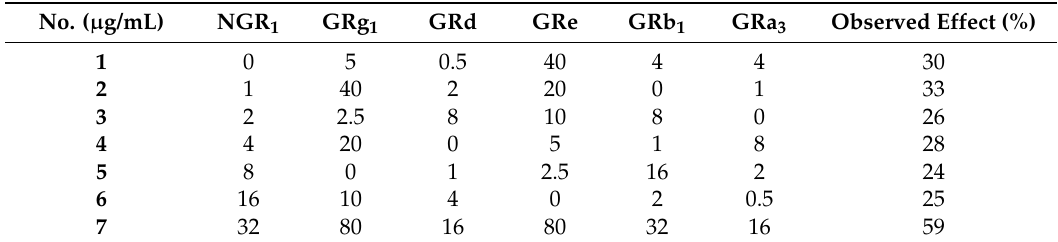
Table 2. The uniform design and the observed anti-platelet aggregation effect of seven different individual saponin combinations in vitro study in example 1.